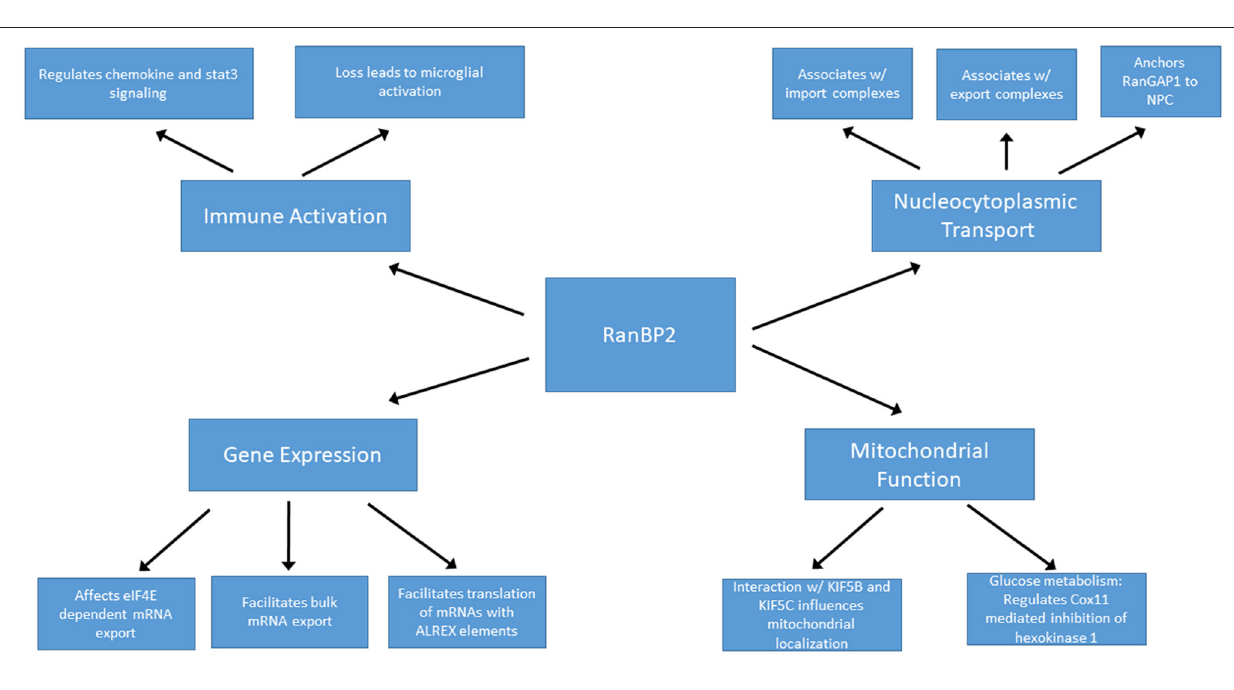
FIGURE 3 | RanBP2 is a multifunctional